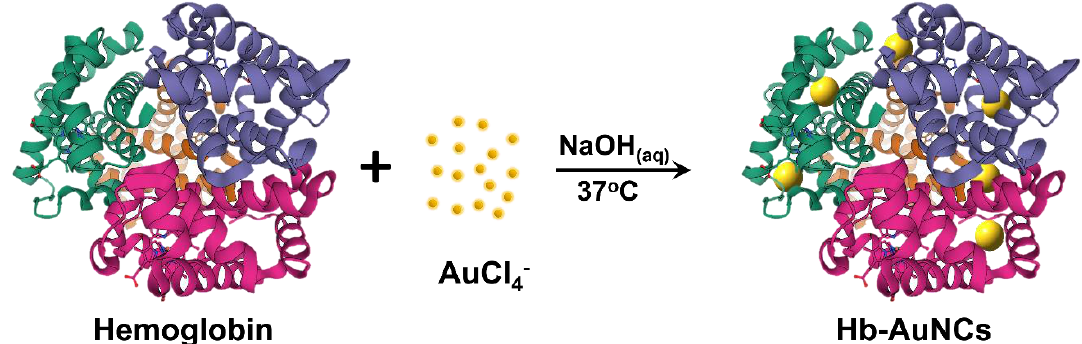
Figure 1. Schematic illustration of hemoglobin-conjugated gold nanoclusters (Hb-AuNCs) synthesis by a facile one-pot synthesis strategy.